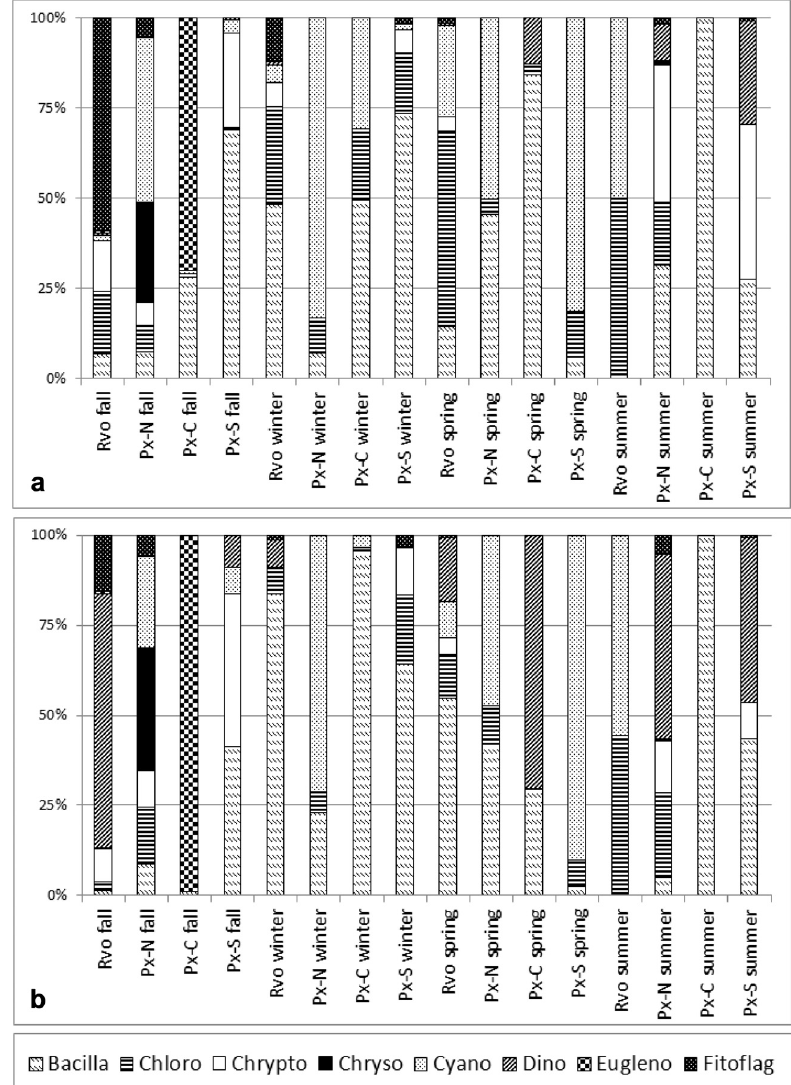
Figure 5 - Relative contribution (%) of density ( a ) and biomass ( b ) of phytoplankton groups in the Ruivo and Peixe lagoons. (Legend for locations see Table